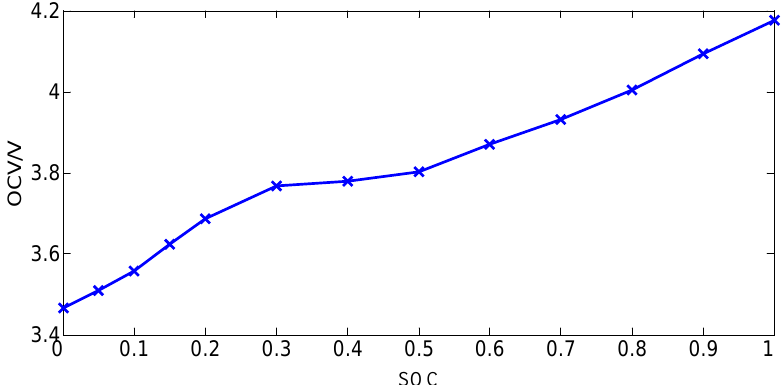
Figure 3. The varying curve of open circuit voltage (OCV) with state-of-charge (SOC).